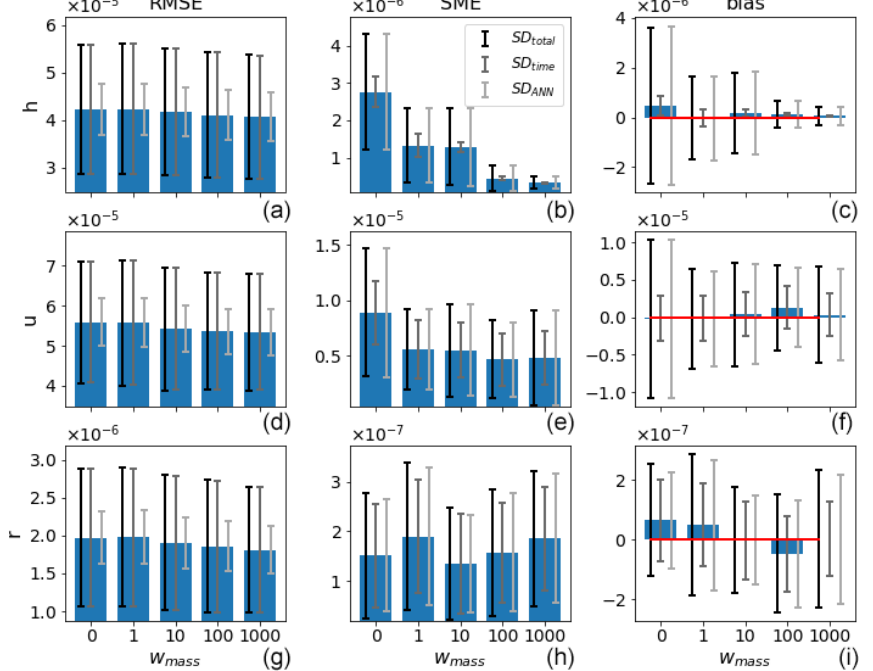
Figure 8. Same as Fig. 7 but for the chaotic case.